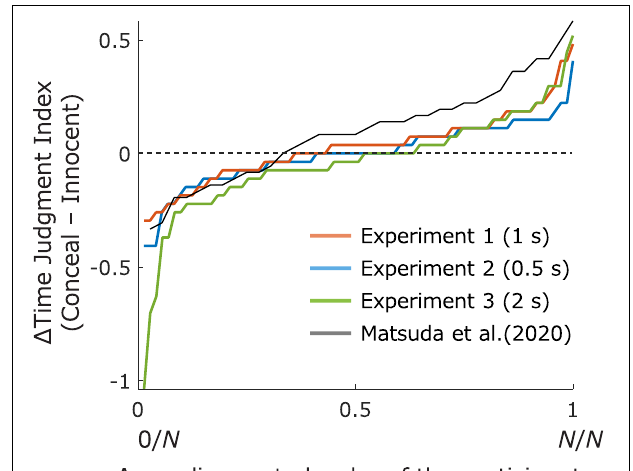
FIGURE 5 | Individual data of the difference in the time judgment index between conditions. The difference was computed between the mean of the Conceal condition and that of the Innocent condition for each participant, which was organized in ascending order. The horizontal axis indicates (ascending order of each participant)/(total number of the participants), whereas the vertical axis indicates the participant’s difference in the mean between conditions. Data from Experiments 1 (blue), 2 (red), and 3 (green), and the previous study (gray) were